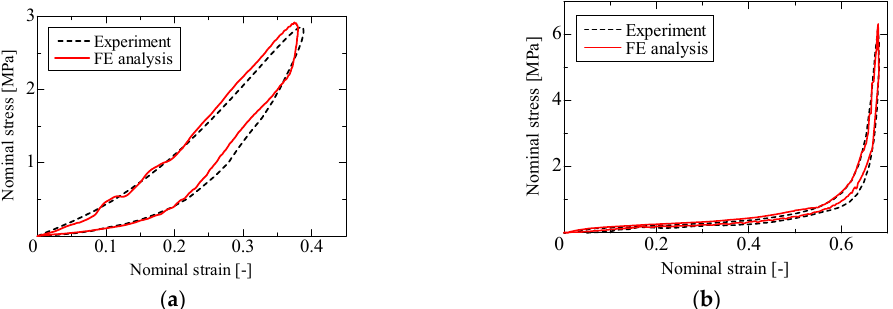
Figure 1. These figures show the results of the s-s curves for the experiments and the FE analyses at a velocity of 3.0 m/s: ( a ) the sheet; ( b ) the